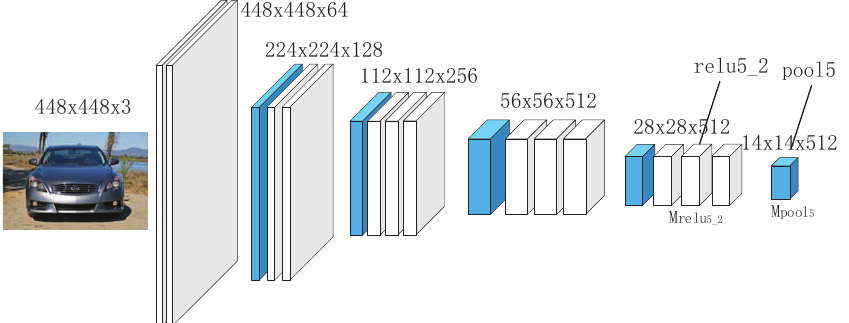
Figure 4. Architecture of VGG-16. The blue layer represents the pooling layer while the white layer represents the convolution and activation